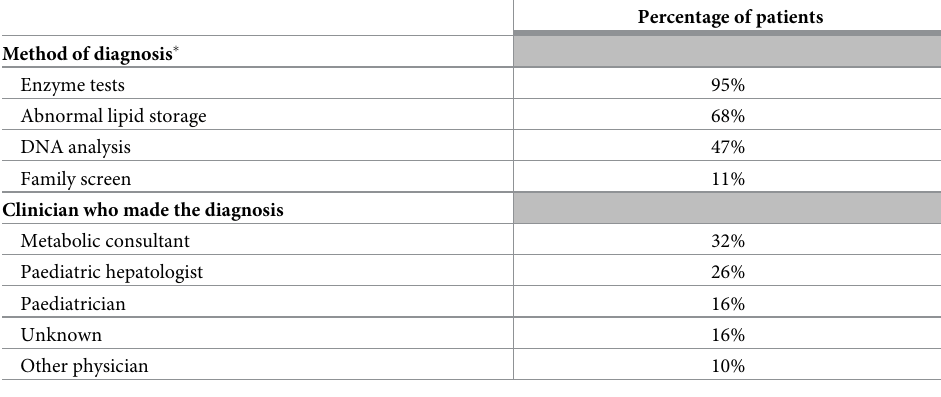
Table 2. Patients’